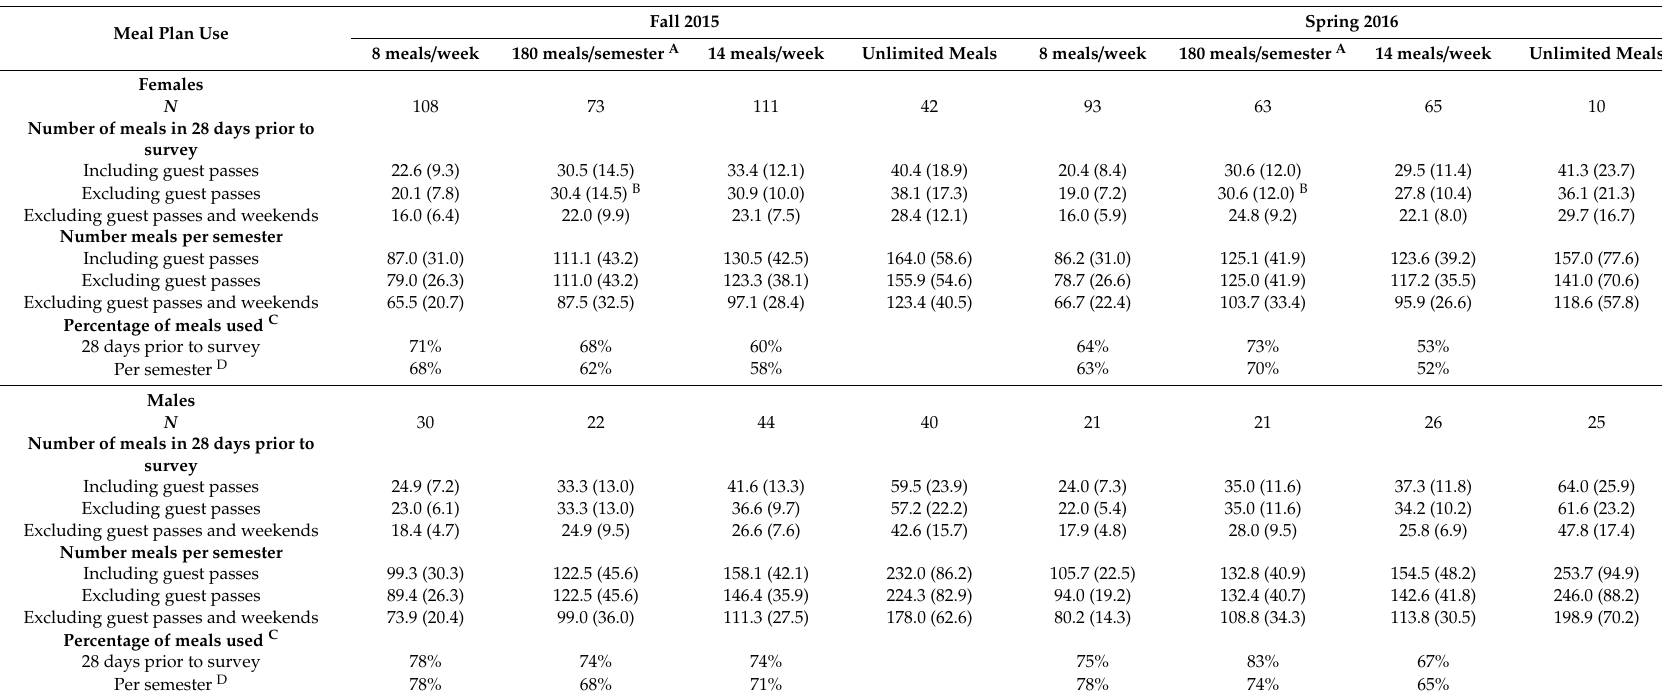
Table 2. The number of meals students used from their meal plan in the 28 days prior to survey, and across the semester ( n = 534; mean